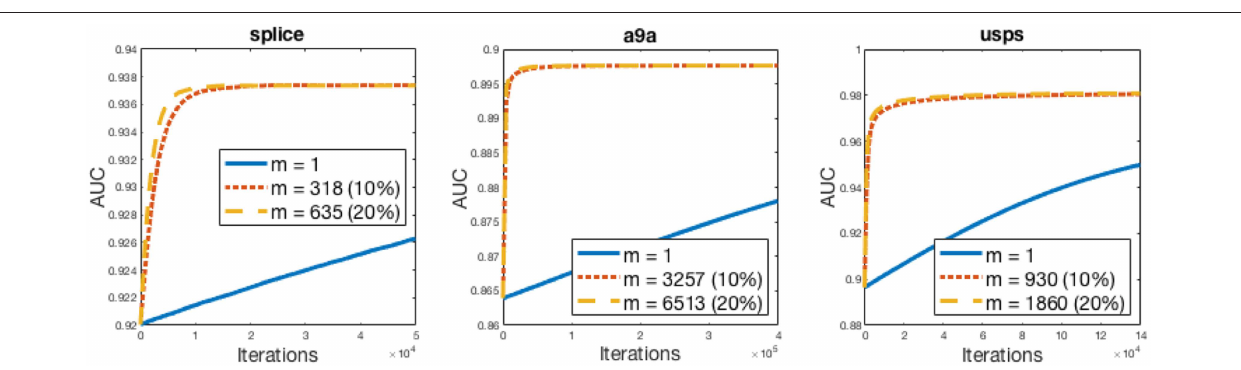
FIGURE 2 | AUC vs. Iteration curves of SPDAM algorithm for various batch sizes. The batch size is a percentage of the number of samples.